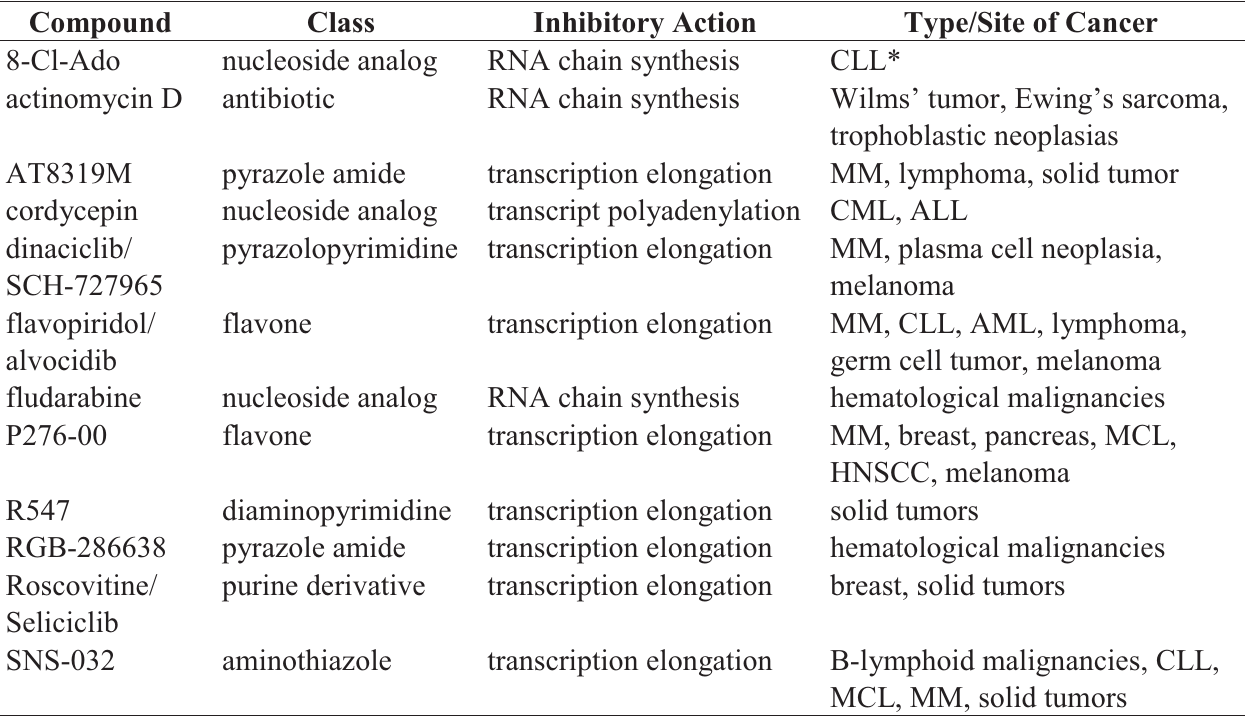
Table 1. RNA-directed agents in clinical trials or in use as standard